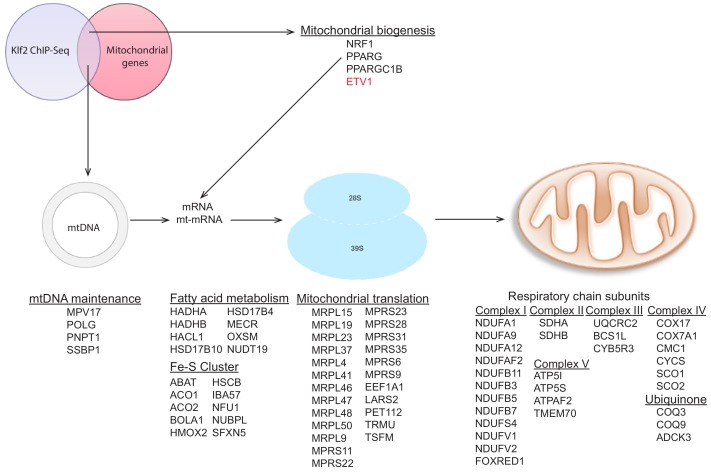
Targets of KLF2 as determined by ChIP-Seq data analysis.Graphic representation of publicly available KLF2 ChIP-Seq data, highlighting its target genes to include several mitochondrial genes. KLF2 target genes from the ChIP-Seq data were crossed with the mitochondrial ‘gene list’ described above to obtain targets of KLF2 which encode mitochondrial proteins. We note that NRF1, PPARG and PPARGC1B are not in the ‘mitochondrial gene list’, since they do not encode bona fide mitochondrial proteins, they were found to be direct targets of KLF2. Interestingly, ETV1, which we describe in this study is also found as a KLF2 target gene. The complete list of KLF2 target genes which encode mitochondrial proteins can be found in Supplementary file 2.